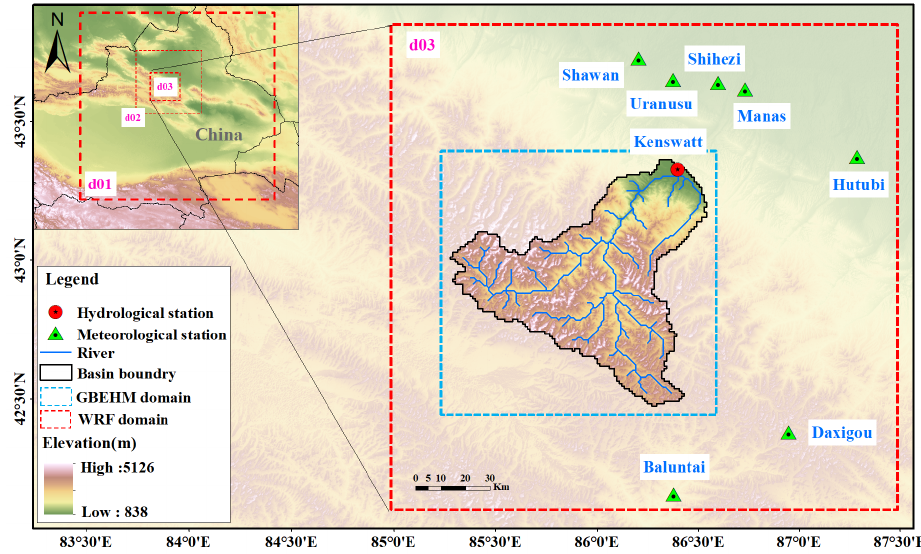
Figure 2. Map of the Manas river basin. The WRF downscaling domain and the hydrological model (GBEHM) simulation domain are illustrated by different rectangles. A schematic representation of the three nesting levels can be seen in the upper left section of the WRF model (d01, d02, d03). The red dashed line shows the operational area of the WRF model domain 3, a 57 × 54 grid with a horizontal resolution of 3.3 km. The yellow dashed line (GBEHM domain) indicates the operational area of the hydrological model, a 111 × 107 grid with a resolution of 1 km. The seven meteorological sites are distributed around the Manas River basin (green triangles). The hydrological outlet gauge (Kenswatt station) is marked with a red